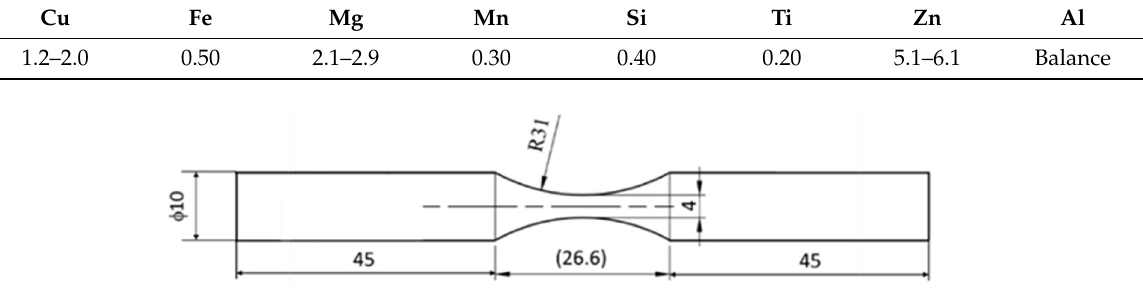
Figure 1. Shape and dimensions (in mm) of the samples used for torsional fatigue tests.